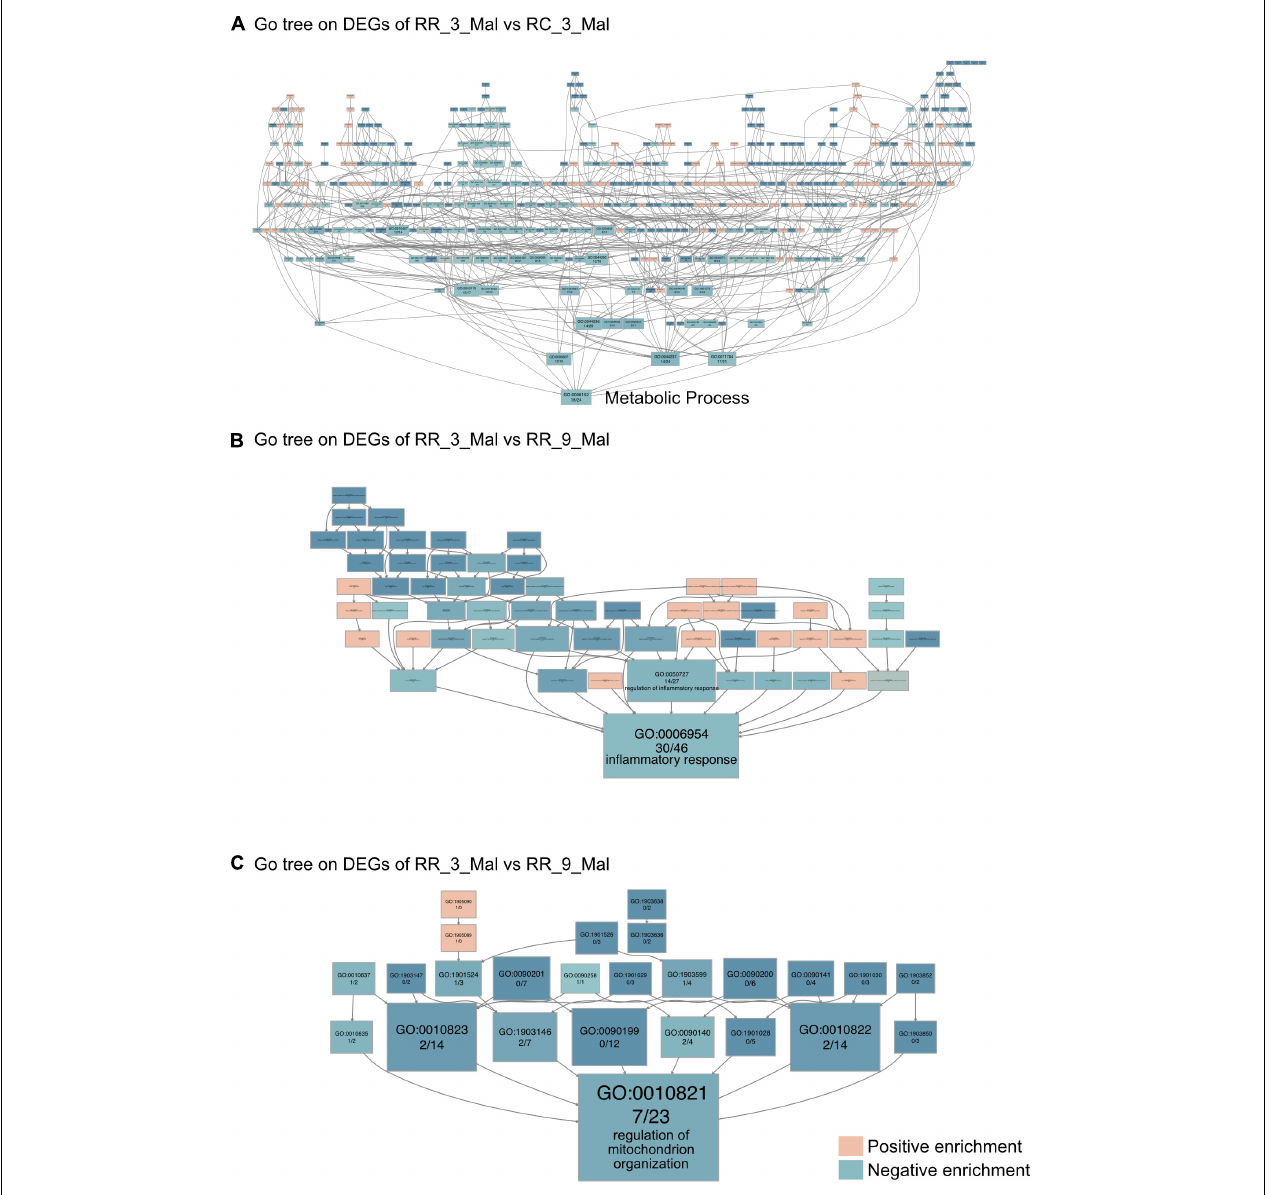
FIGURE 4 | Continuous low-protein diet aggravates mitochondrial dysfunction in the heart. (A) The GO tree of RR_3_Mal vs. RC_3_Mal on the heart. (B) The GO tree of 76 inflammatory-related DEGs in inflammatory response (GO:0006954). (C) The GO tree of 30 mitochondrion-related DEGs in the regulation of mitochondrion organization (GO:0010821). The box color equated to the numbers of upregulated and downregulated DEGs, with upregulated represented by pink and downregulated equaling blue.